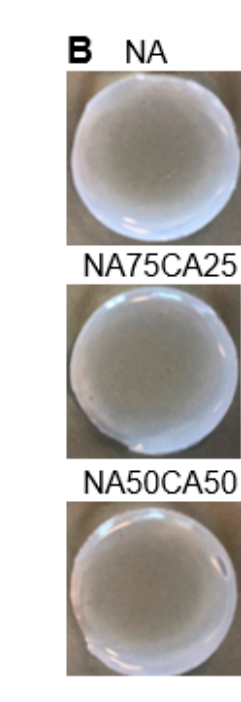
Figure 2. ( A ) UV-visible spectra of the three formulations showing a higher transparency in the NA50CA50 sample. ( B ) Photography of the hydrogel pad showing the opacity of each formulation. NA: native agarose; CA: carboxylated agarose.